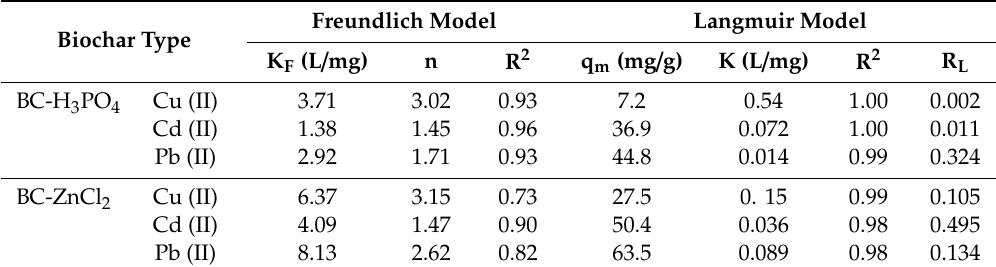
Table 3. Isotherms fitting parameters of the Freundlich and Langmuir models for the BC-H 3 PO 4